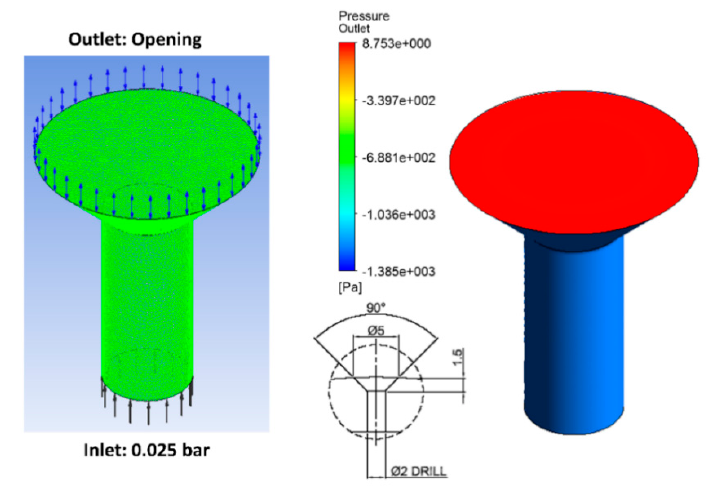
Figure 3. Detail of an air hole, and the pressure distribution from the inlet to the outlet.